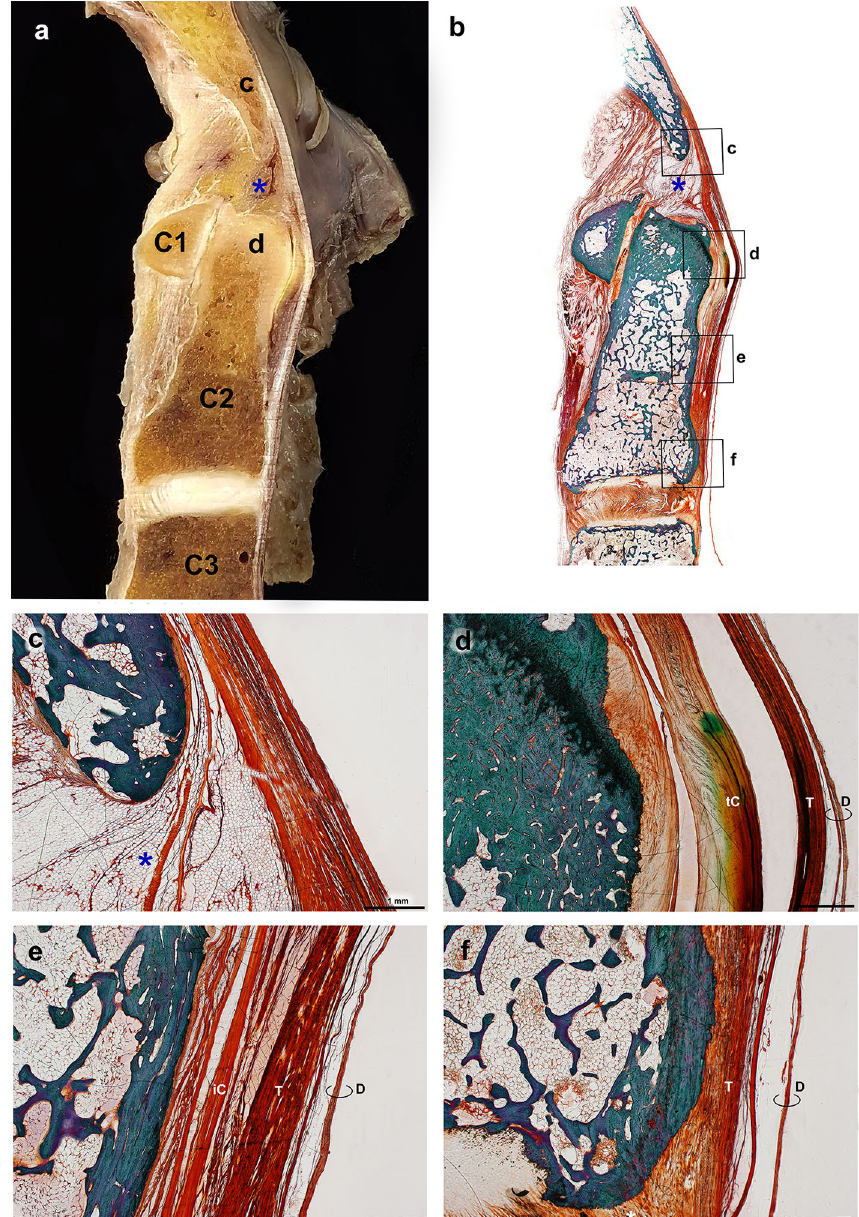
Figure 5. Sagittal view of the craniovertebral junction. Gross hemisection ( a ) and a plastic embedded section by Goldner’s Trichrome stain ( b ) of the same specimen. Dark orange stain indicates dense connective tissues attached to the bony tissue (green stain). c clivus, d dens. ( c – f ) Show magnifications of boxes of a whole specimen. ( c ) The inferior clivus forms the superior border of the supradental space (asterisk) filled with adipose tissues. ( d ) The cruciate ligament–tectorial membrane (TM)–dura mater complex in the impingement site of a dens. Arrows indicate a calcified transverse ligament of the cruciate ligament. ( e ) The fibers of the inferior crus of the cruciate ligament are close to the TM in the body of the axis. ( f ) A deep layer of the TM is firmly attached to the connective tissues of the intervertebral space between the axis and C3 (white asterisk), except for the superficial layer of the TM and spinal dura mater. D dura mater, iC inferior crus of the cruciate ligament, tC transverse ligament of the cruciate ligament, T tectorial